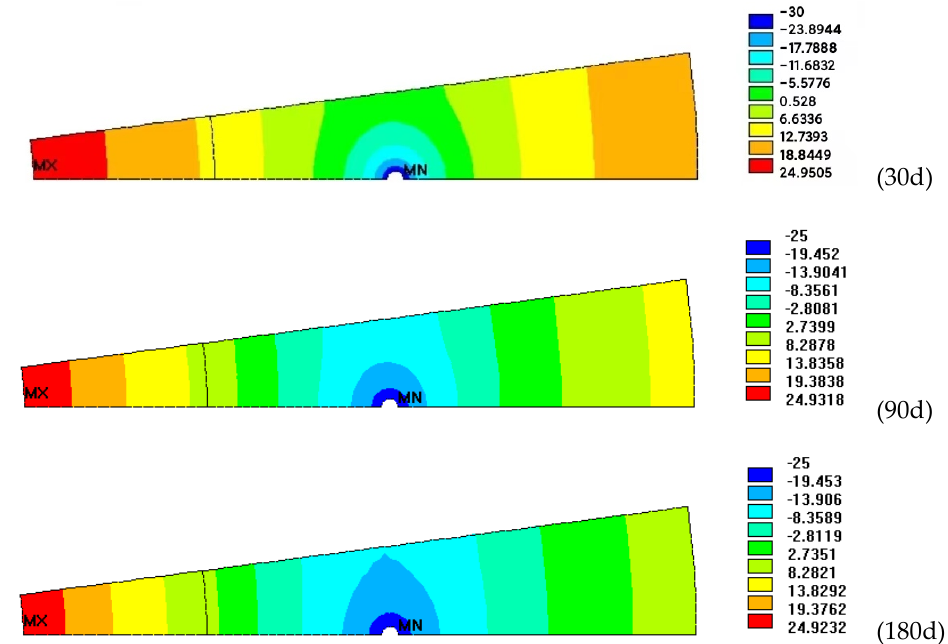
Figure 9. Temperature contours within 30d, 90d, and